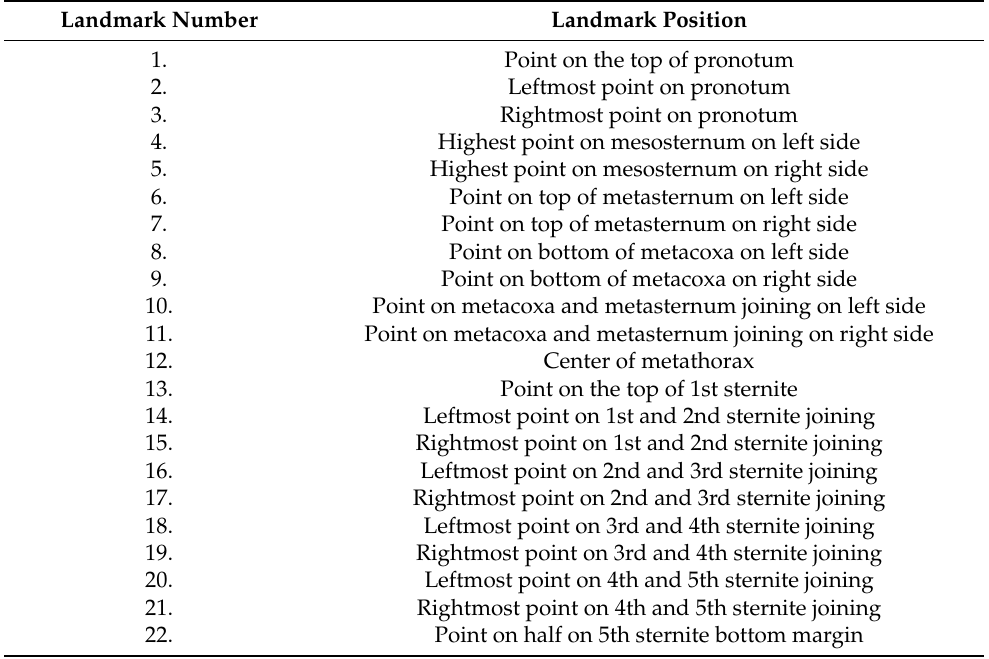
Table 1. Definitions of landmarks on the Acanthoscelides obtectus